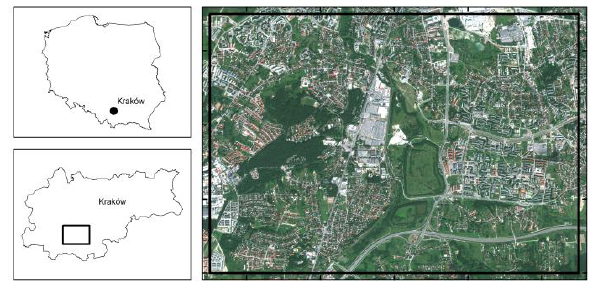
Figure 1. Localization of study site. Left top: border of Poland, Left bottom: City of Krakow borders, right: GeoEye satellite image (bands: 321) of the study